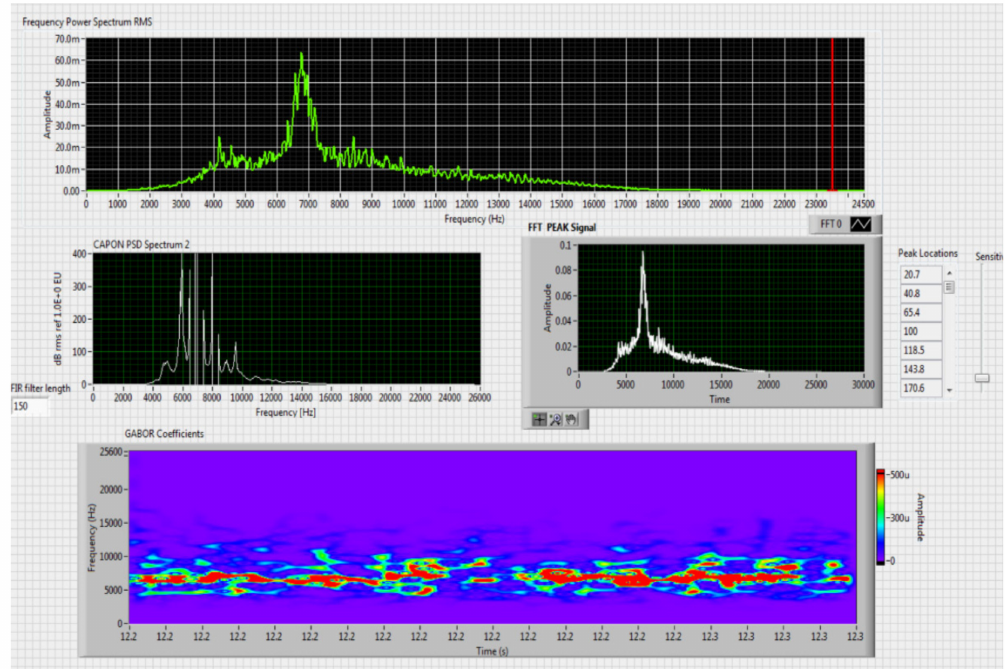
Figure 18. Results obtained for stationary distance 80 m, moving altitude 2–10